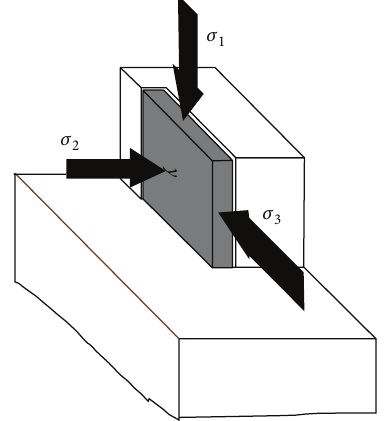
Figure 2: Sketch of a true triaxial loading